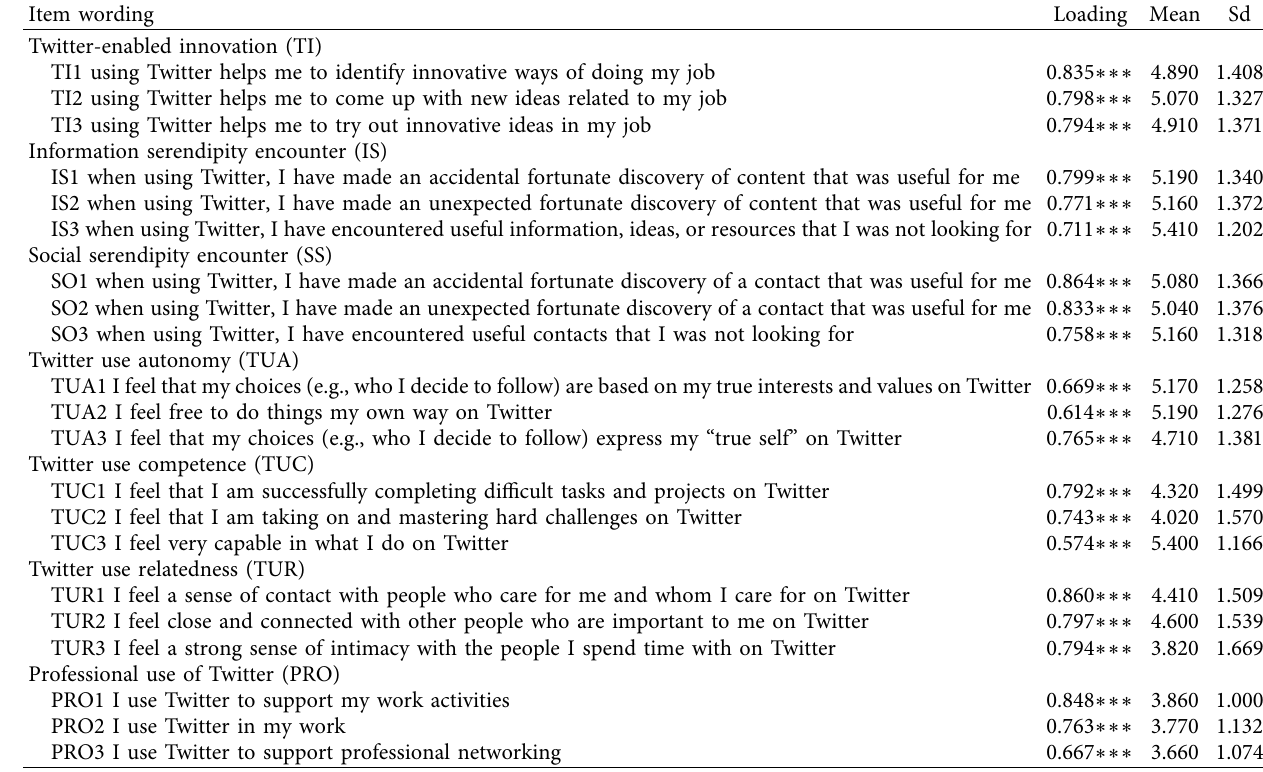
Table 2: Items, standardized CFA loadings, means, and standard deviations.